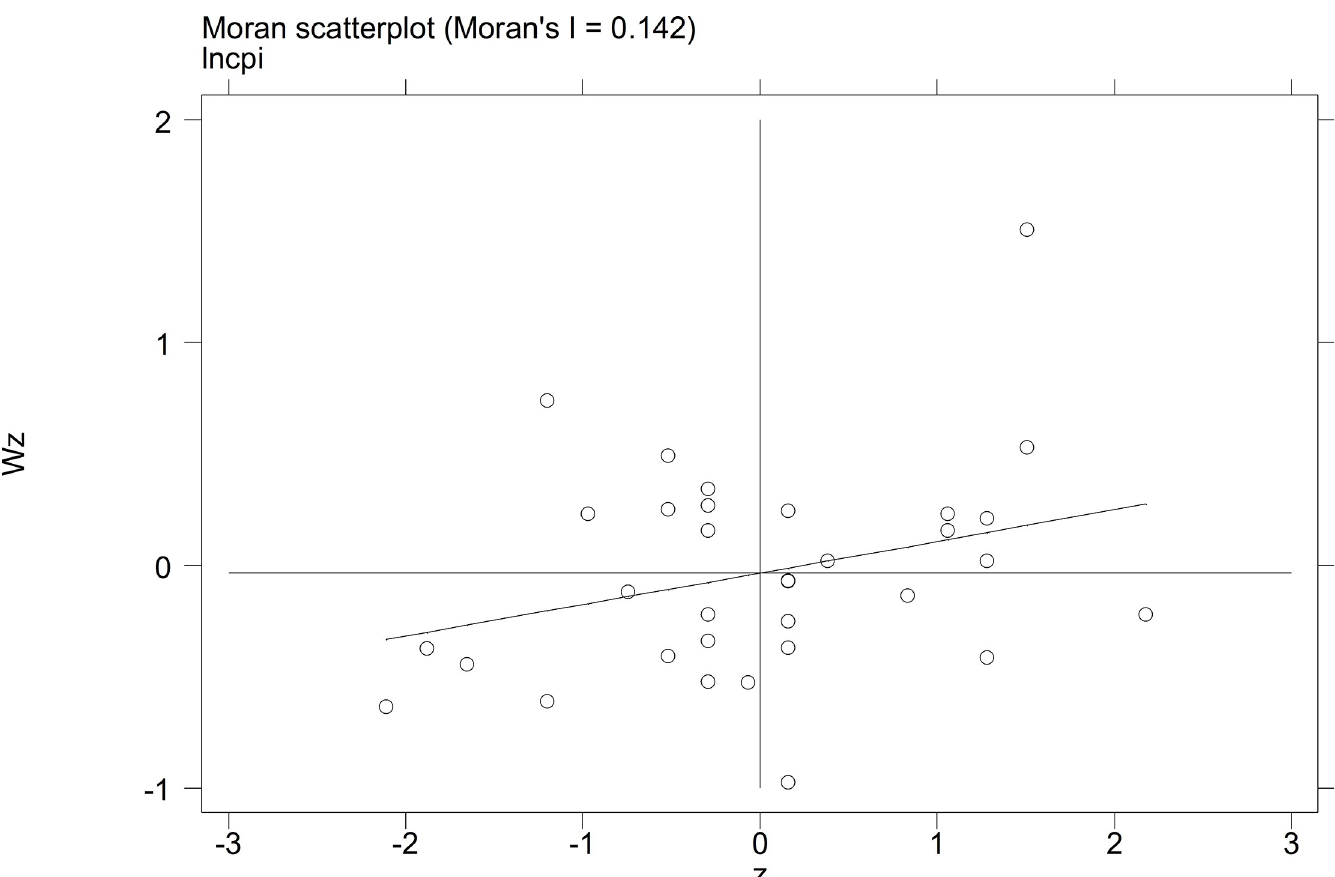
Fig 6. Scatterplot of Moran’ I for CPI in Dec.